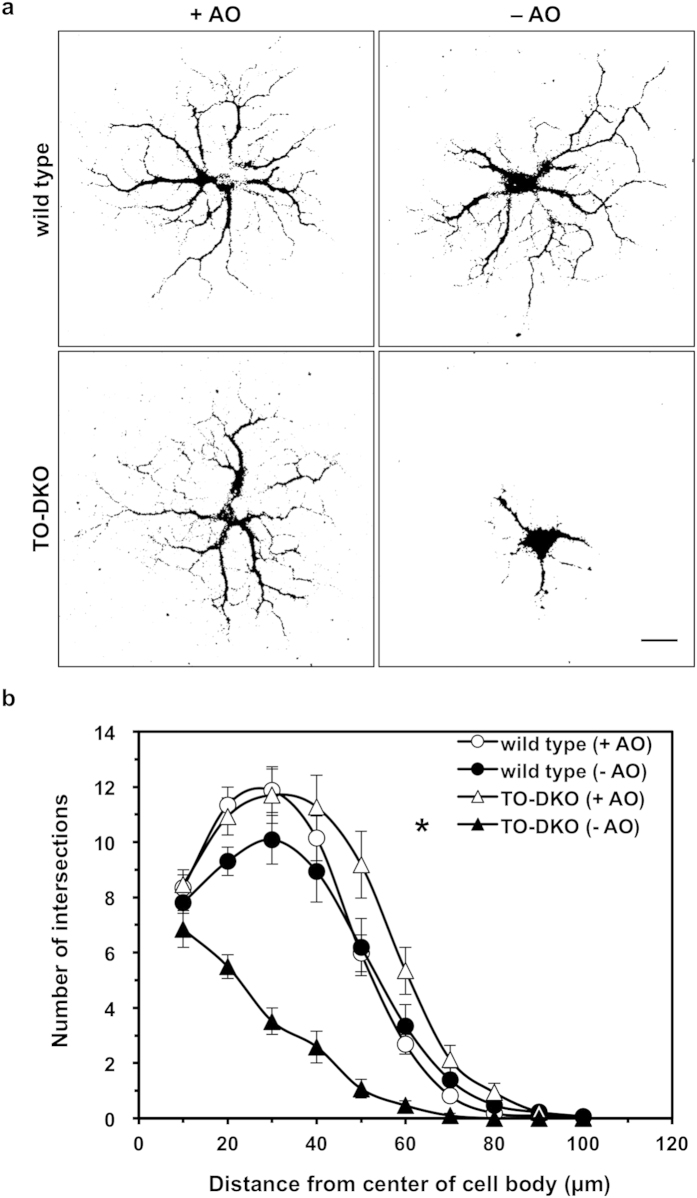
Neurite arborisation of cortical neurons isolated from adult Mth1/Ogg1-DKO but not wild-type mice was significantly impaired in the absence of antioxidants.(a) Adult cortical neurons isolated from Mth1/Ogg1-DKO (TO-DKO) and wild-type mice were cultured for 5 days in the absence (−AO) or presence (+AO) of antioxidants and were subjected to MAP2-immunofluorescence microscopy. Representative images are shown, indicating a simpler neuritic branching pattern in neurons from TO-DKO mice cultured in the absence of antioxidants. Scale bar = 20 μm. (b) Sholl’s concentric sphere analysis shows severely impaired neurite arborisation in TO-DKO neurons in the absence of antioxidants. More than 16 neurons were examined in each culture condition. Combined data from two independent experiments are shown. Error bar = SEM. MANOVA, between subjects: F(3, 171) = 19.671, p < 0.0001; within subjects: interaction, p < 0.0001 (Univar G-G, ε = 0.311). TO-DKO (−AO) vs. other three groups, *p < 0.0001.